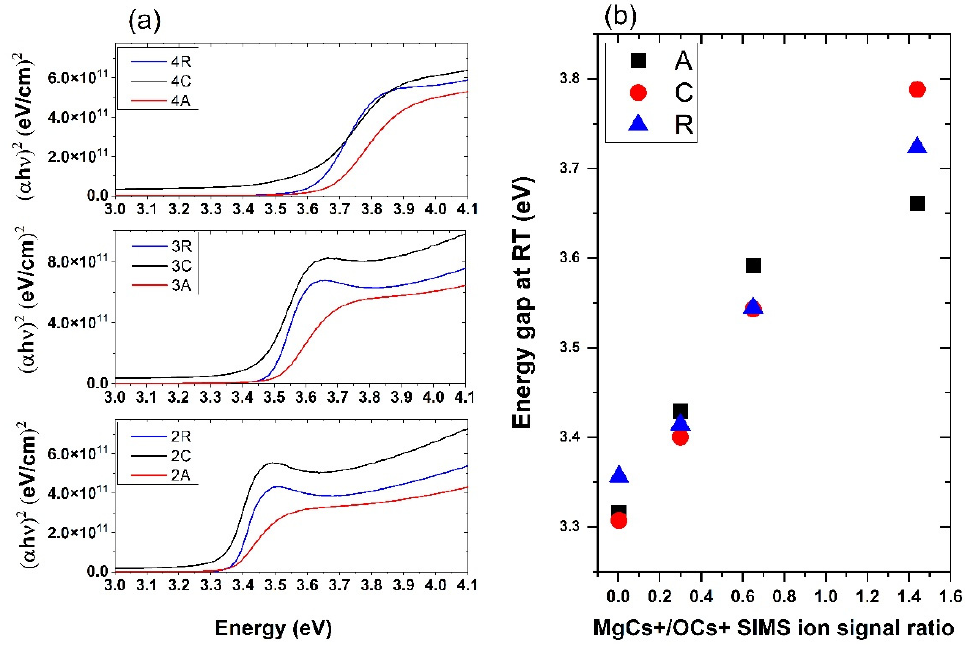
Figure 5. ( a ) Tauc plots for series of Zn 1 − x Mg x O samples grown on differently oriented sapphire substrates. ( b ) Energy gap vs. MgCs + /OCs + SIMS ion signal ratio.